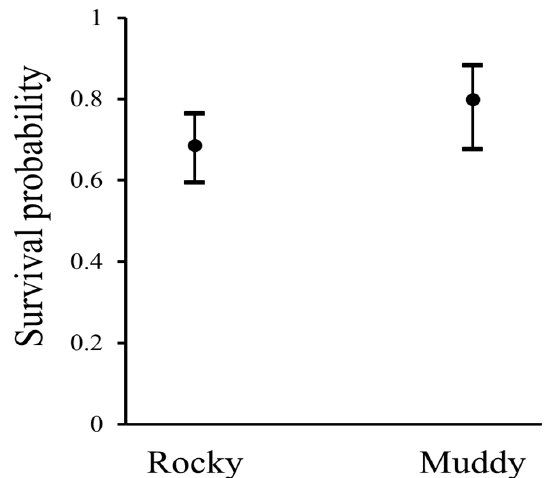
Figure 3. Survival probability in relation to stream substrate type for the second-best model for the Chocoan River Turtle on Isla Palma estimated using multi-state mark-recapture models (error bars = 95% confidence interval).